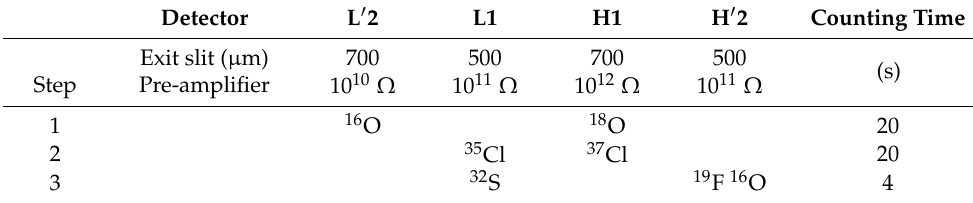
Table 3. Configuration of the multi-collector used for simultaneous